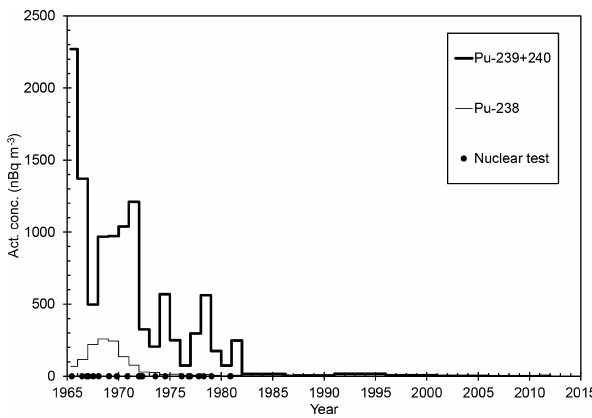
Figure 1. The activity concentration of 238 Pu (thin line; in nBqm − 3 ) and 239 + 240 Pu (thick line; in nBqm − 3 ) in the surface air of Rovaniemi in 1965–2011. Values below the detection limit have been depicted as half the MDA (minimum-detectable-activity) value (Table 1). The black circles indicate the times of atmospheric nuclear tests (UNSCEAR,